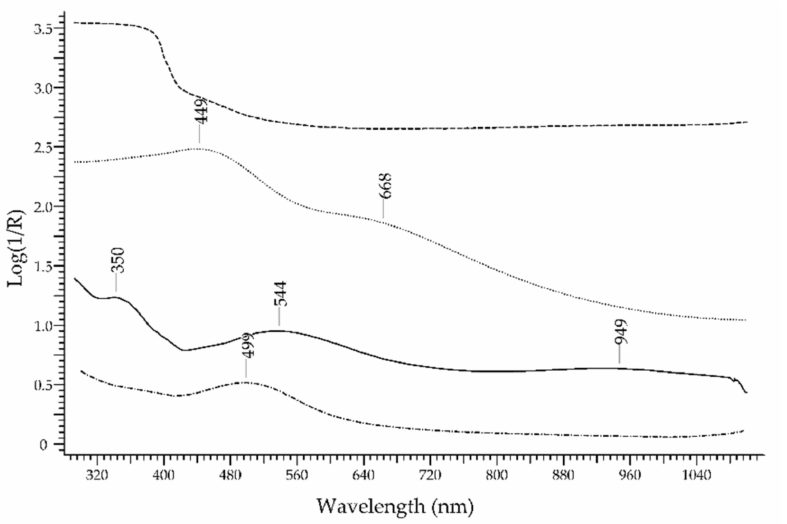
Figure 15. FORS spectrum in Log(1/R) coordinates of amethyst (solid line), citrine quartz (dashed line), smoky quartz (dotted line) and rose quartz (dashed–dotted